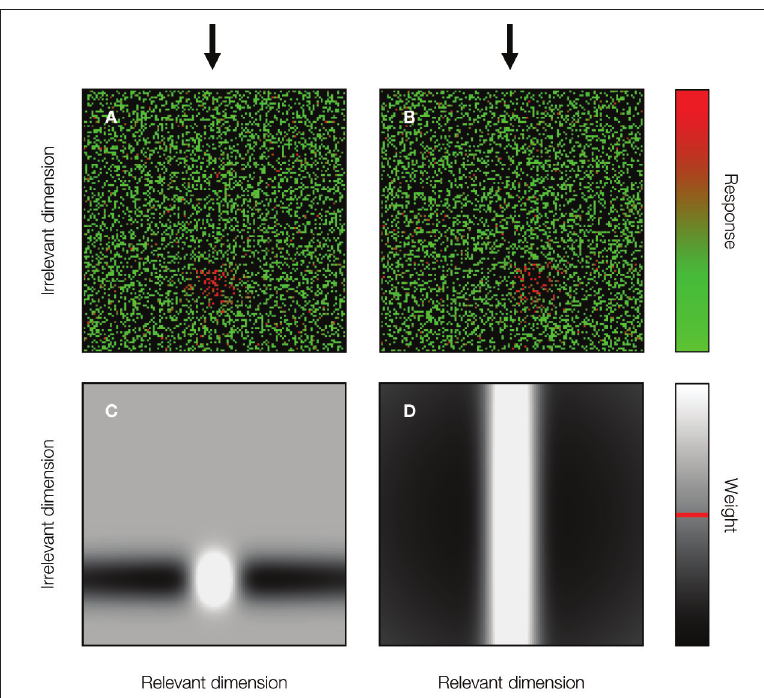
Figure 2 | Identification is weight optimization. To classify each stimulus in an identification task (explained in detail in Figure 3A ), an optimal linear classifier bases its decision on the (thresholded) weighted sum of responses (Green and Swets, 1966). Neurons tuned to the target location are weighted positively while neurons tuned to the non-target locations are weighted negatively (the red line in the lower legend indicates the grey level matching zero). Non-informative neurons are ignored (i.e., they receive a weight equal to zero). (A) Responses of a pool of simulated IT-neurons to a 2-D stimulus. Each neuron’s response is plotted at the neuron’s preferred stimulus location. Only one of the stimulus dimensions is relevant for the identification task. The target location on the relevant dimension is indicated by the black arrow. The stimulus shown to the neural network is at the target location. (B) Same as (A) for a stimulus at a non-target location. The stimulus location on the irrelevant dimension has not changed. (C) The normalized decision template of a classifier optimized for identification at one specific location on the irrelevant dimension. Neurons tuned to stimulus locations remote from the target and distracter stimuli are not informative, and thus do not contribute to the decision. (D) The normalized decision template of a classifier optimized for identification at all possible locations on the irrelevant dimension.